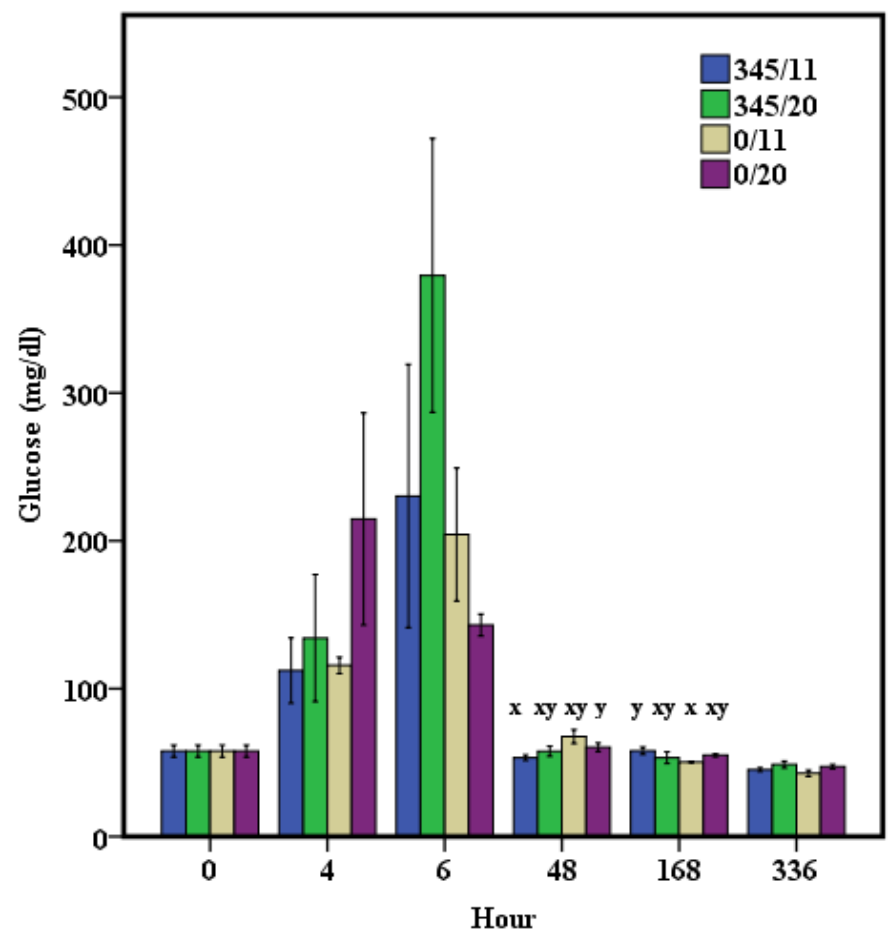
Figure 4. Trial 4 glucose levels ( ± SE) at the beginning (hour 0—before transfer, basal hardness of 345 mg/L and 11 ◦ C) and 4, 6, 48, 168, and 336 hours after the start of the trial when rainbow trout Oncorhynchus mykiss ( n = 4 for each treatment at each timepoint) were directly transferred from 345 mg/L water hardness and 11 ◦ C to experimental conditions without acclimation. For a given timepoint, means with a different letter are significantly different ( p < 0.05).